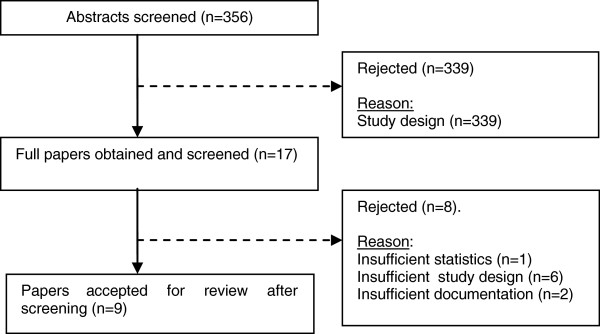
Flowchart of papers.